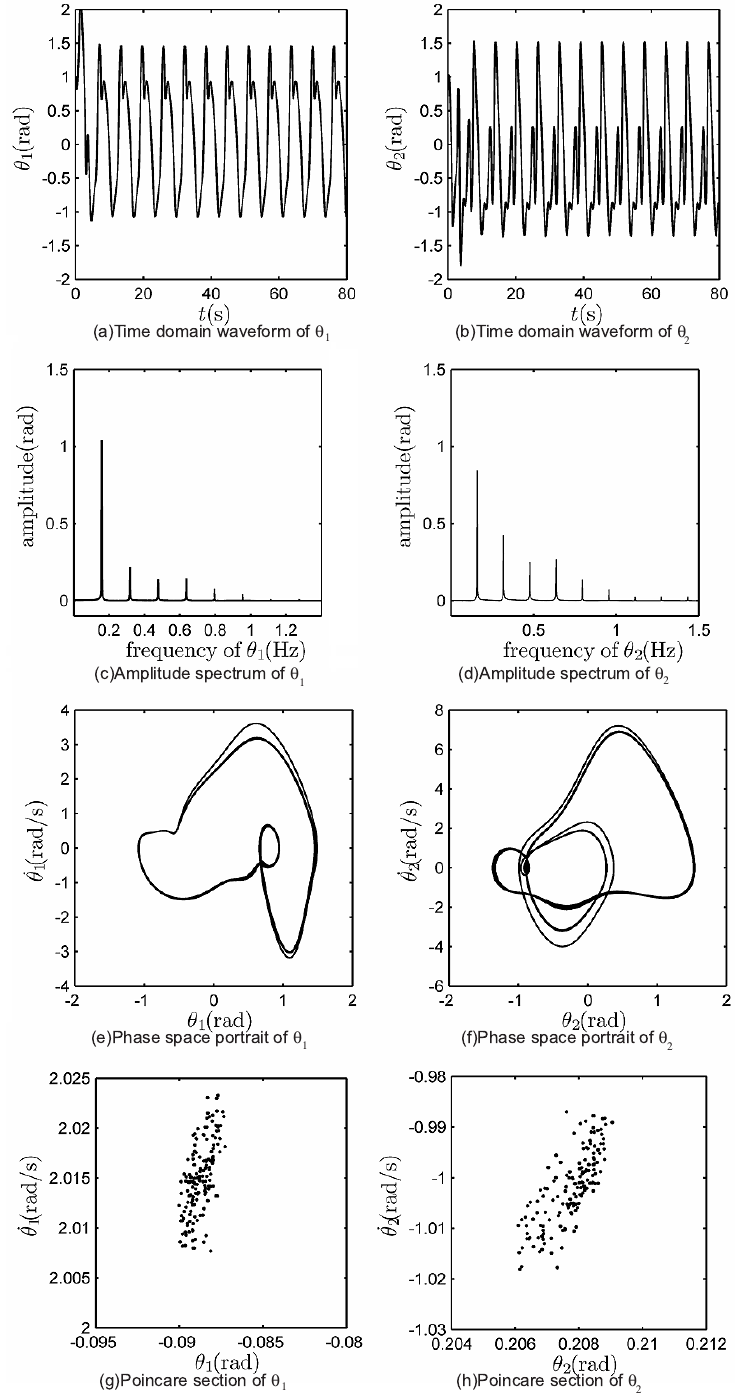
Fig. 4. The simulated multiple-periodic motions [(a) Time domain waveform of θ 1 , (b) Time domain waveform of θ 2 , (c) Amplitude spectrum of θ 1 , (d) Amplitude spectrum of θ 2 , (e) Phase space portrait of θ 1 , (f) Phase space portrait of θ 2 , (g) Poincare section of θ 1 ,(h) Poincare section of θ 2